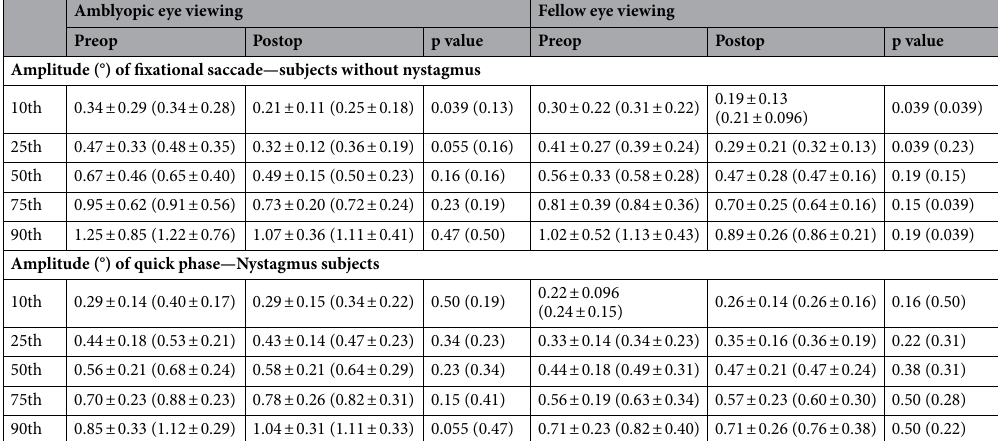
Amblyopic eye viewing Fellow eye viewing Preop Postop p value Preop Postop p